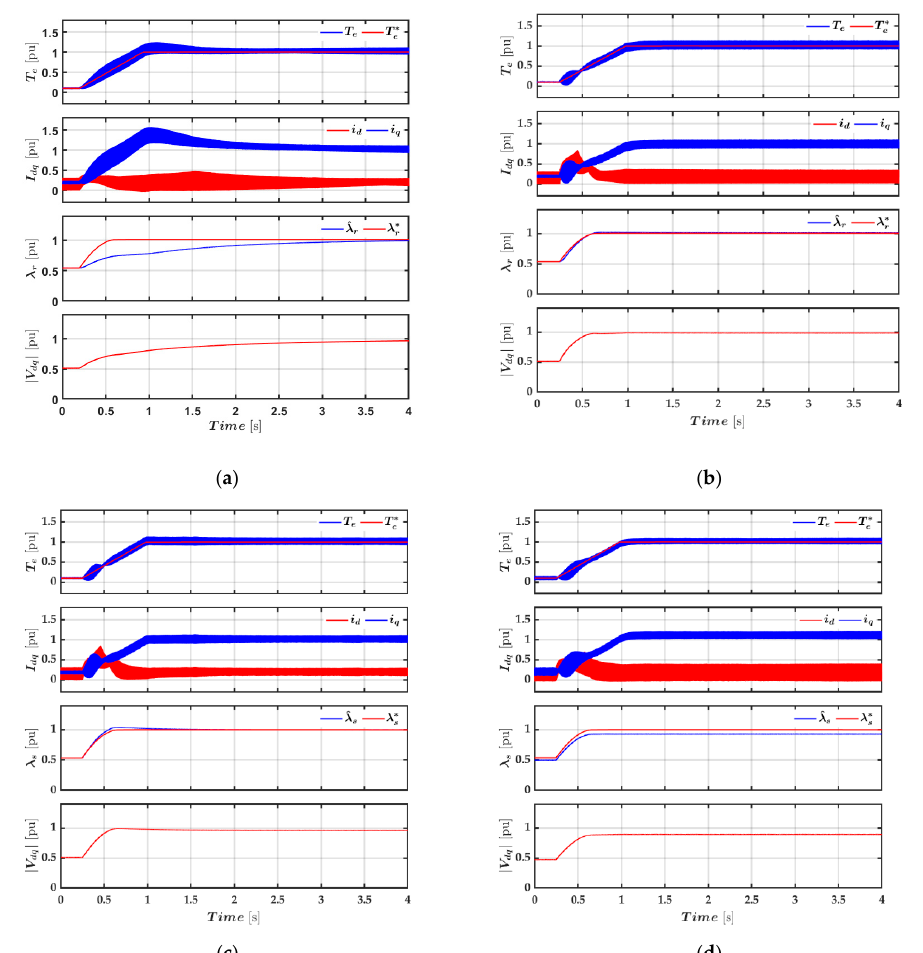
Figure 18. Simulation results of using ( a ) CLVFC, ( b ) CLVFC&FF, ( c ) DFVC, and ( d ) DTC-SVM control methods with SHE. Rotor speed 𝜔 (cid:3045) = 1.328𝜔 (cid:3029)(cid:3028)(cid:3046)(cid:3032) ; torque was increased from 10% (i.e.,